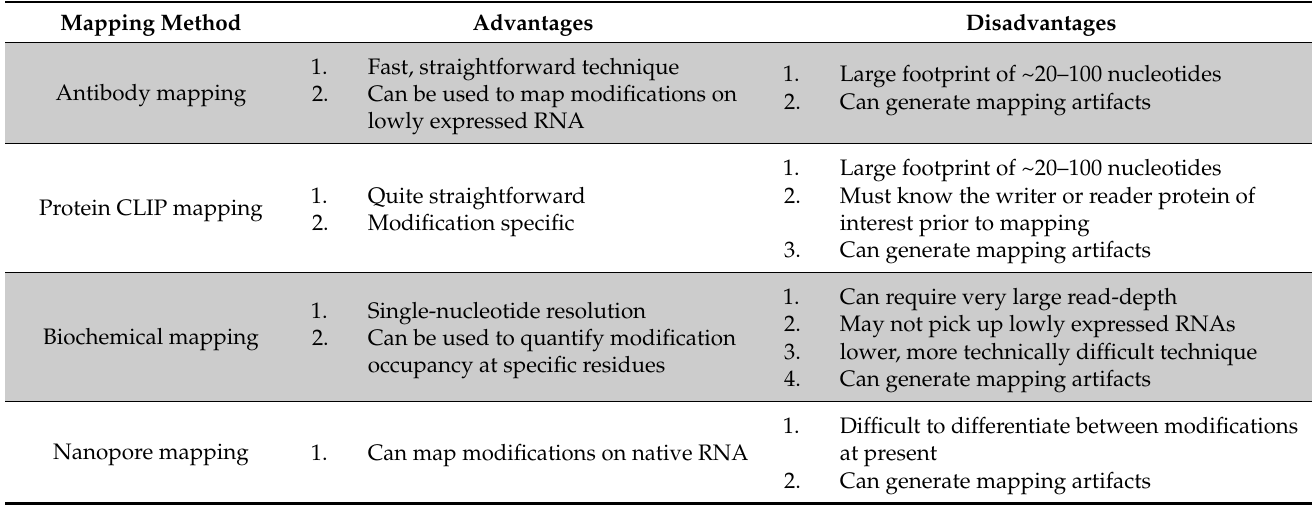
Table 3. A summary of the advantages and disadvantages of the forms of mapping techniques described in this review. Mapping